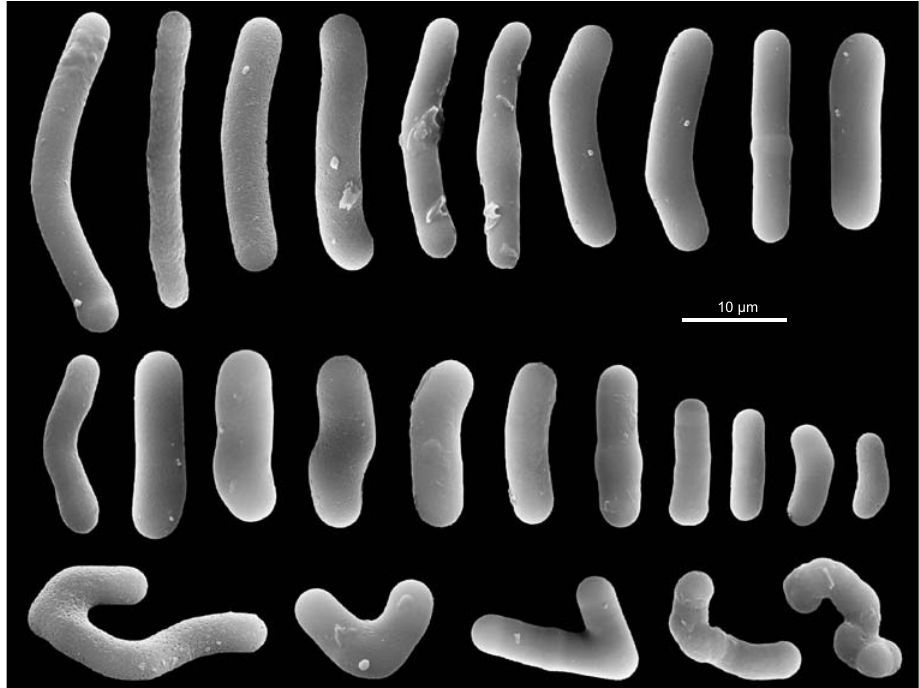
Fig. 17. Potamophloios canadensis Pisera, Siver, and Wolfe, 2013, Spongillida: Potamolepidae, ZPAL Pf23; Lutetian, middle Eocene, Giraffe Kimberlite maar, Northern Canada. Strongyles (gemmuloscleres) in a wide dimensional range. Malformed spicules (bottom row). SEM images. Modified from Pisera et al. (2013).